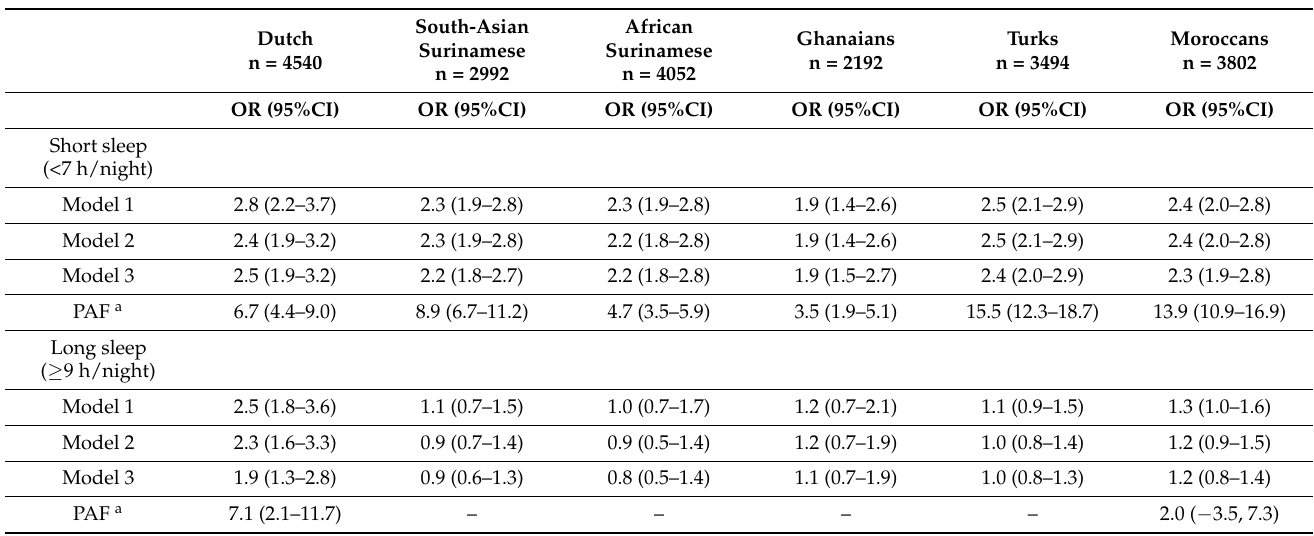
Figure 1. Association between depressed mood and short sleep duration among six ethnic groups living in Amsterdam. Table 2. The association (expressed as odds ratio (OR)) of depressed mood with the prevalence of short sleep and with the prevalence of long sleep duration, by